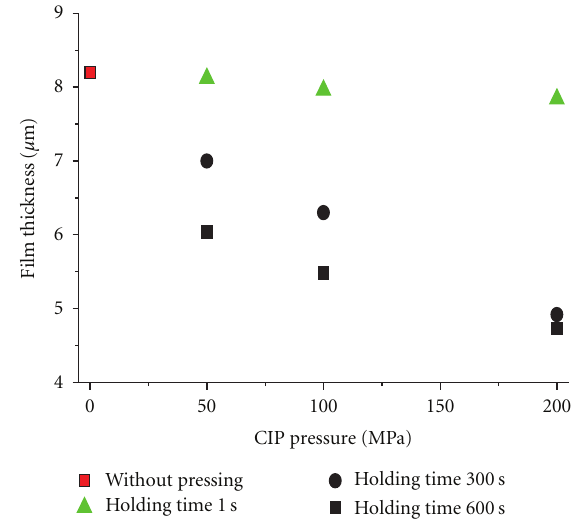
Figure 7: TiO 2 film thicknesses after CIP compressing at di ff erent conditions; the film thickness before CIP pressing was 8.2 μ